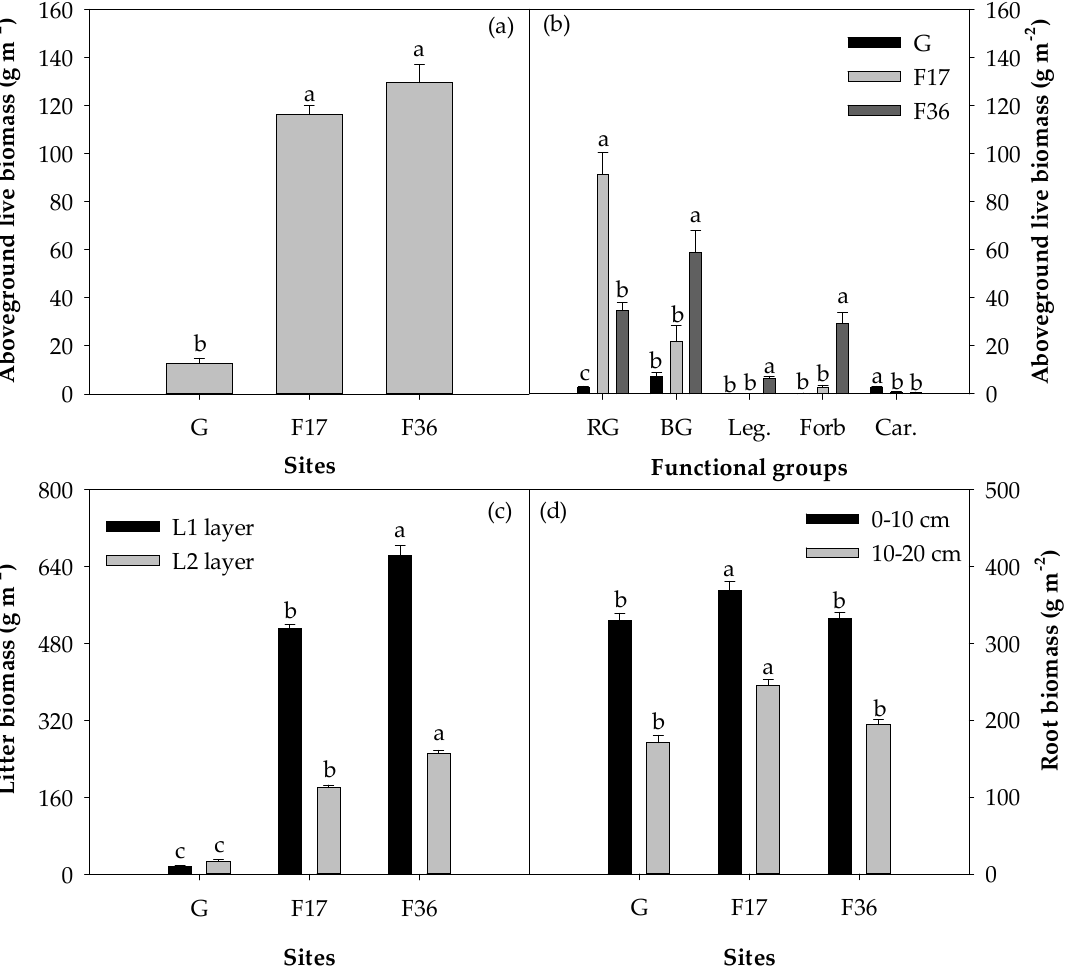
Figure 2. Variations in ( a ) aboveground live biomass, ( b ) aboveground live biomass of rhizome grass (RG), bunchgrass (BG), legume (Leg.), forb (Forb) and carex (Car.), ( c ) litter biomass (L1 and L2 layers) and ( d ) root biomass (0–10 and 10–20 cm) among free grazing (G), 17 (F17) and 36 years of fencing (F36) treatments. The values (mean ± SE) are means of five blocks; the same letters above the bars indicate no significant difference at the 0.05 level.